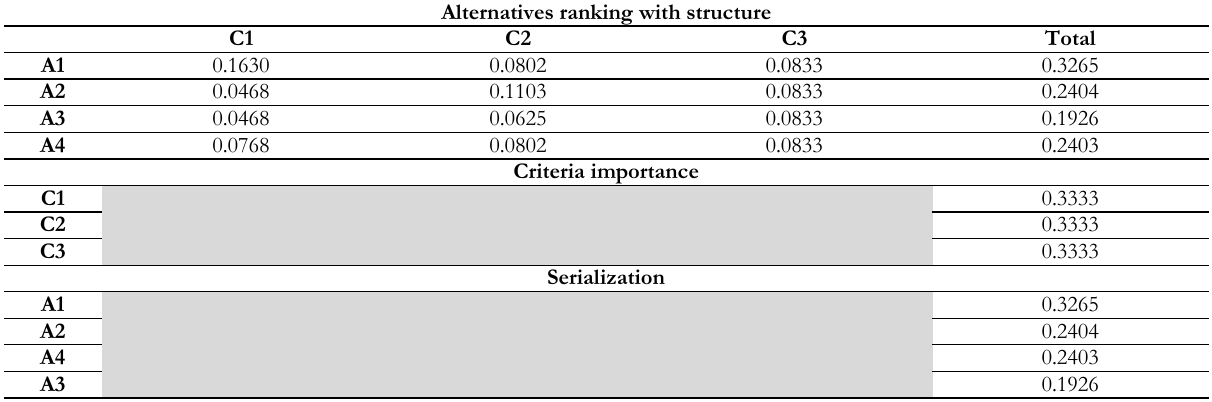
Table 3. Applying AHP method to scenario